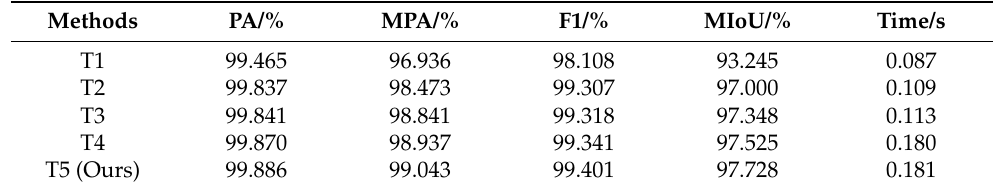
Table 1. The results of each experiment on the synthesized assembly depth image dataset.